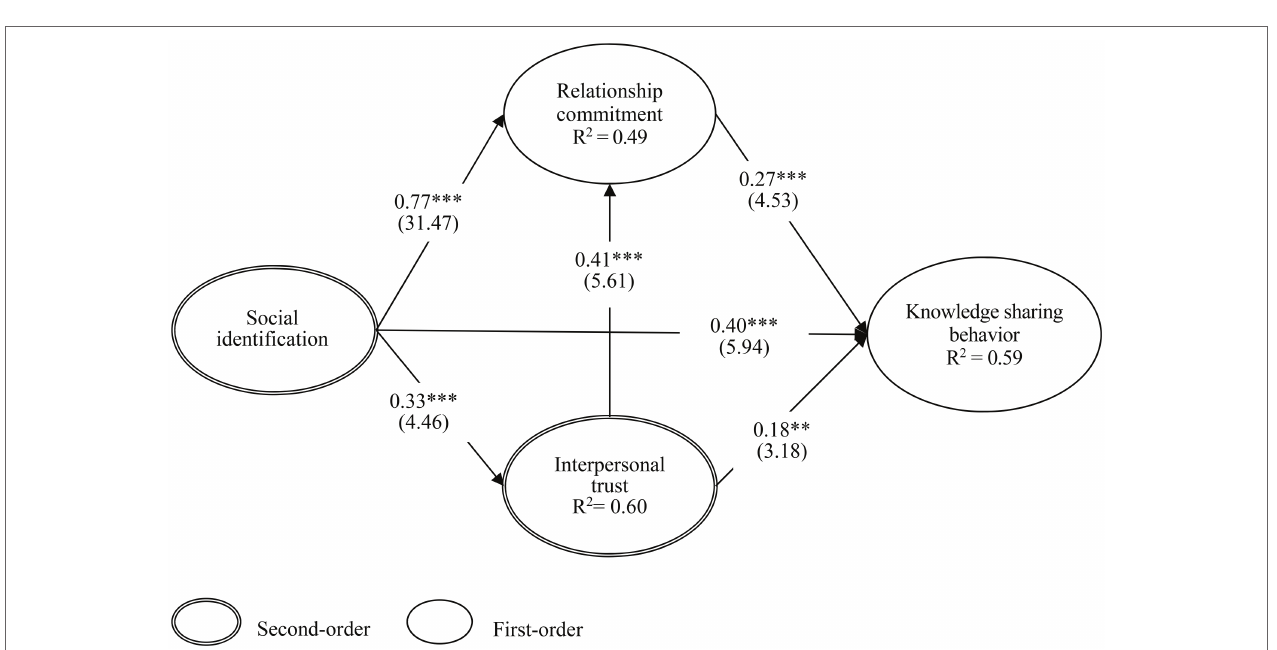
FIGURE 2 | Results of path coefficient, t -value, and R square. *** p < 0.001; ** p < 0.01; Parentheses is t -value.